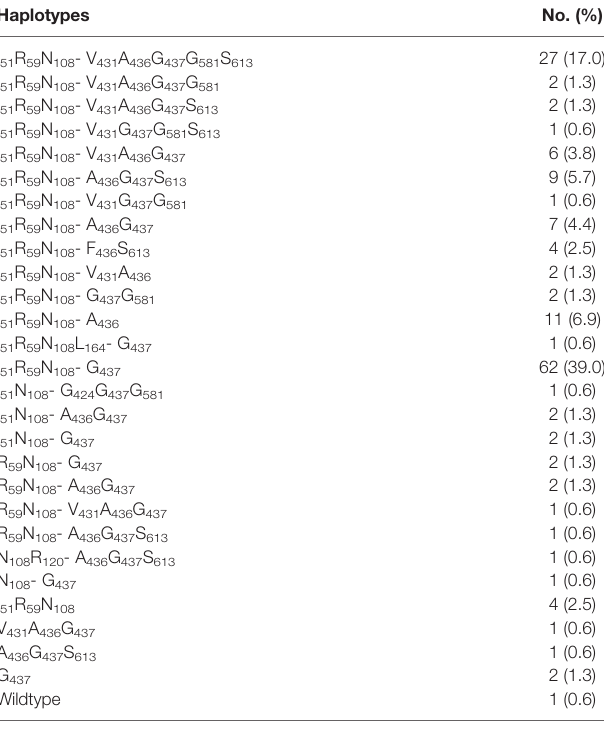
TABLE 3 | Combination of the Pfdhfr and Pfdhps genes detected from Plasmodium falciparum isolates returned from Nigeria during 2012 – 2019. Haplotypes No.